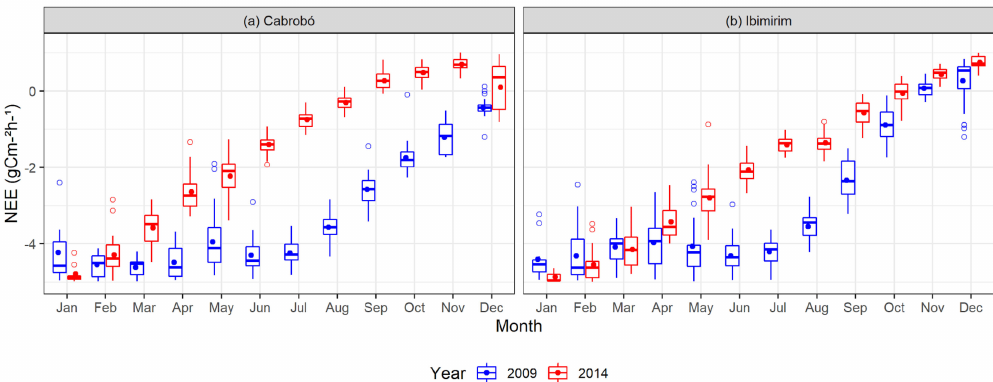
Figure 11. Monthly boxplots of hourly simulated net ecosystem exchange (NEE) in the Cabrob ó and Ibimirim sites in 2009 (wet year) and 2014 (dry year). Regarding NEE values, negative values represent carbon uptake, while positive values represent carbon